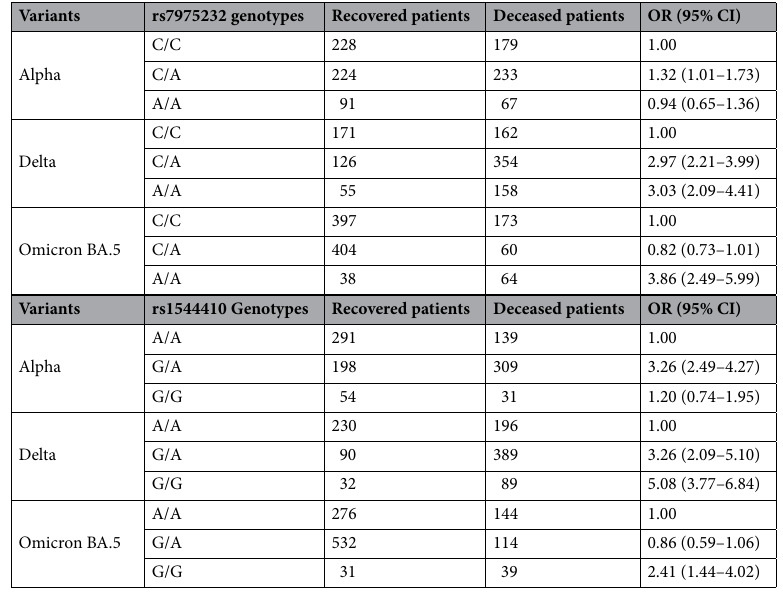
Table 3. ApaI rs7975232 and BsmI rs1544410 genotypes association with SARS-CoV-2 variants. SARS-CoV-2 severe acute respiratory syndrome coronavirus 2, OR odds ratios, CI confidence intervals.